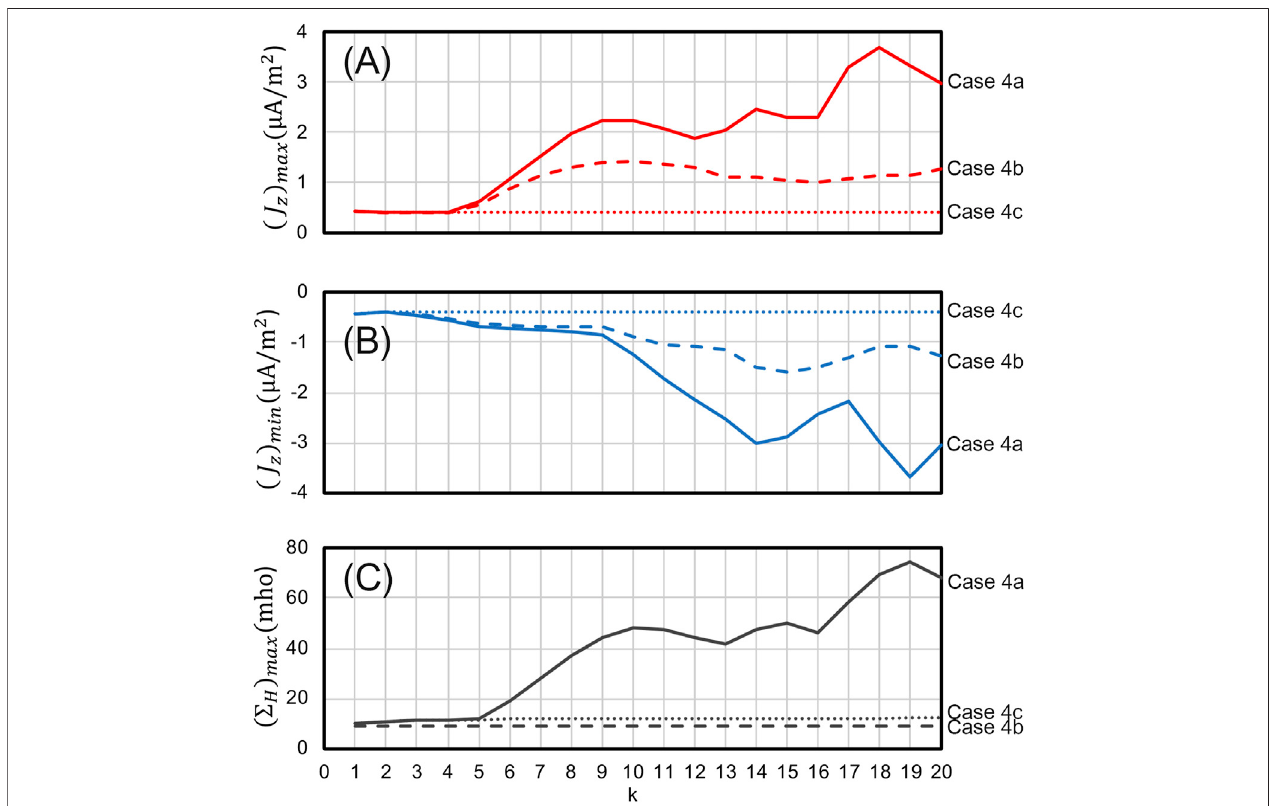
FIGURE6| Thetime evolutionof (A) ( J z ) max , (B) ( J z ) min , and (C) ( Σ H ) max obtainedfrom thesimulations ofCase 4a(the solidcurves), Case4b(the dashed curves), andCase4c(thedottedcurves).SimulationCases4a,4b,and4carecharacterizedbyuniformhighconductances ( Σ H (cid:1) 9mho ) atthebeginningofthesimulations.The conductance enhancement scheme is turned off in Case 4b. The plasma sheet Hall effect is turned off in Case